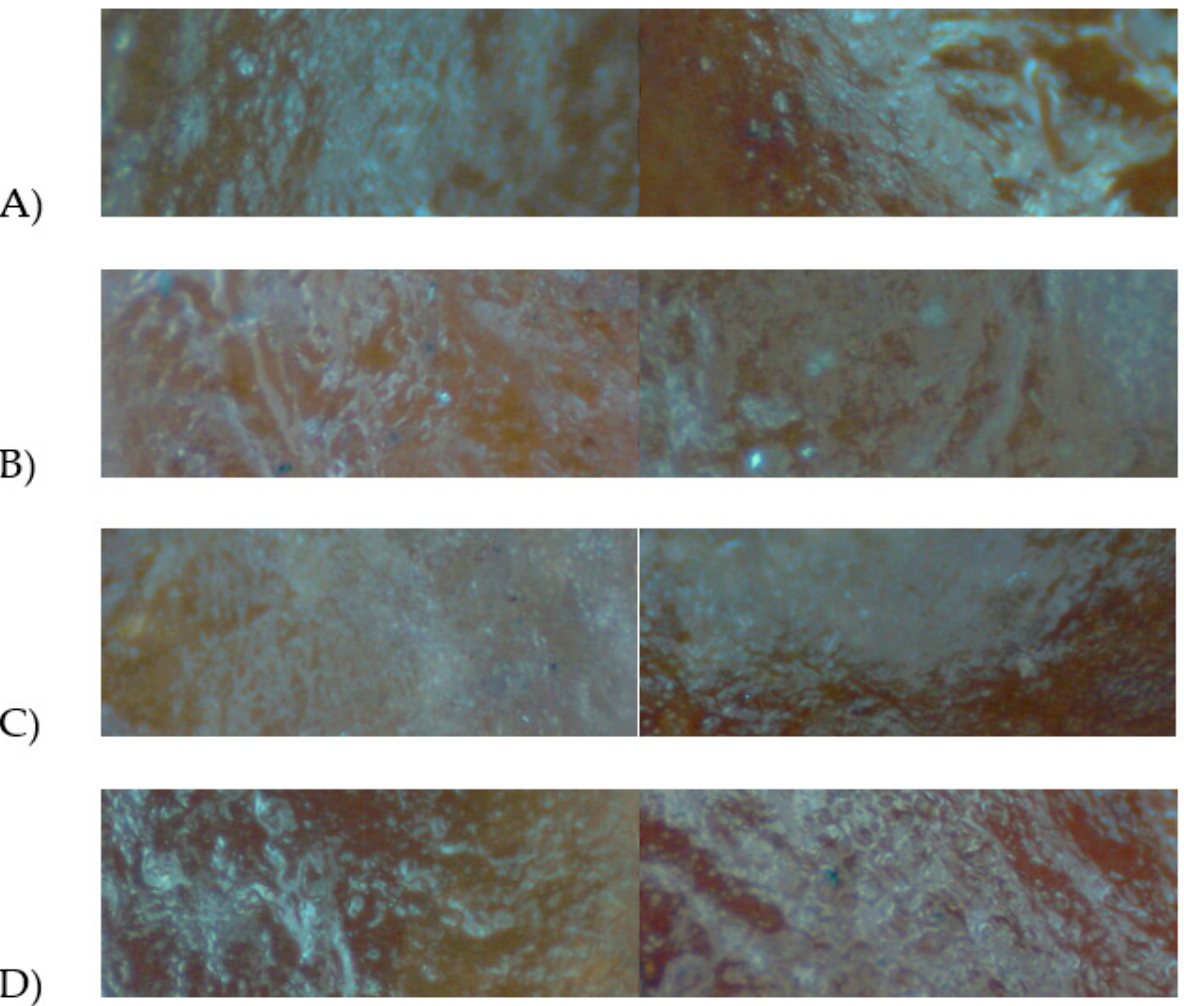
Figure 8. Comparison of date surfaces under various processing conditions, under pressure and with no US: ( A ): 7.5 MPa; ( B ): 12 MPa; ( C ): 15 MPa; ( D ): no processing.